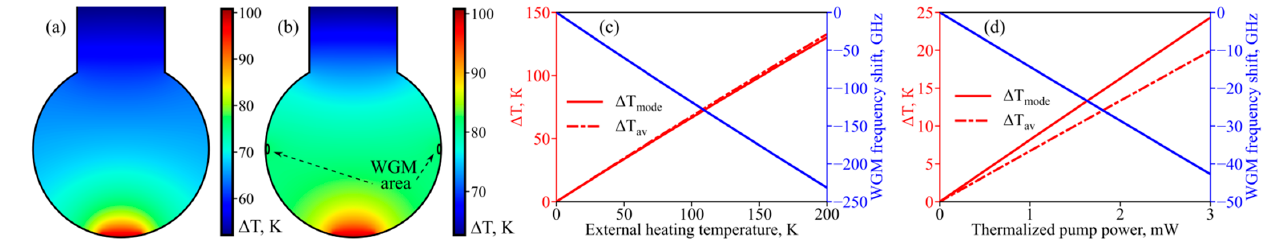
Figure 3. Numerical simulation. ( a ) Temperature distribution in functionalized silica microsphere with 180 µm diameter for coating temperature increase Δ T coating = 100 K for thermalized pump power 0 mW ( a ) and 2 mW ( b ). ( c , d ) Temperature increases averaged over microsphere (red solid line, left axis) and WGM volume (red dash-dotted line, left axis) as well as the corresponding WGM eigenfrequency shift (blue line, right axis) as functions of Δ T coating ( c ) and thermalized pump power (assuming Δ T coating = 0 K) ( d ).